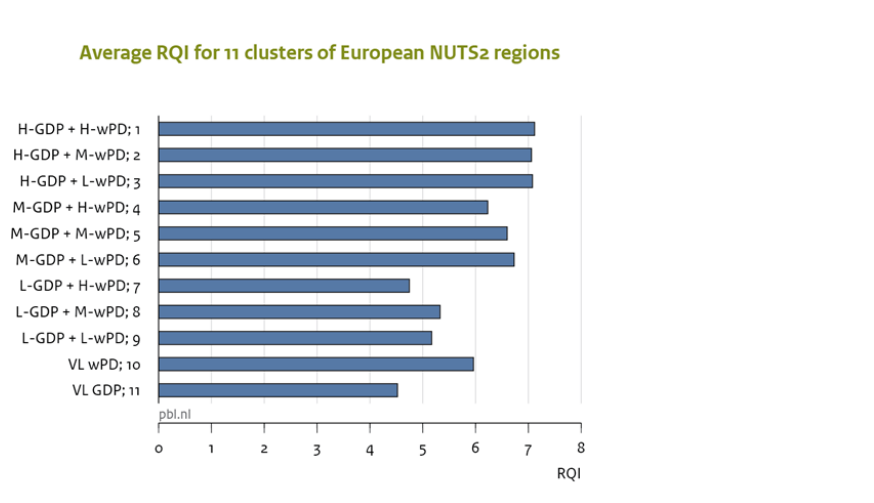
Figure 8: Average RQI values for the European Nuts2 regions for 11